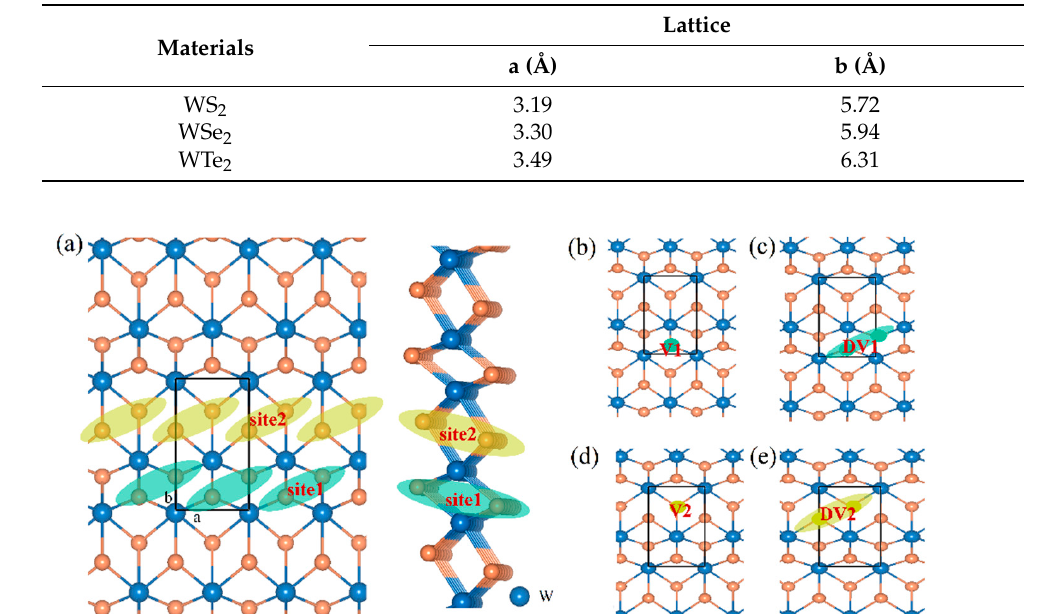
Table 1. Lattice parameters a and b of the 1T’ W-based dichalcogenides.